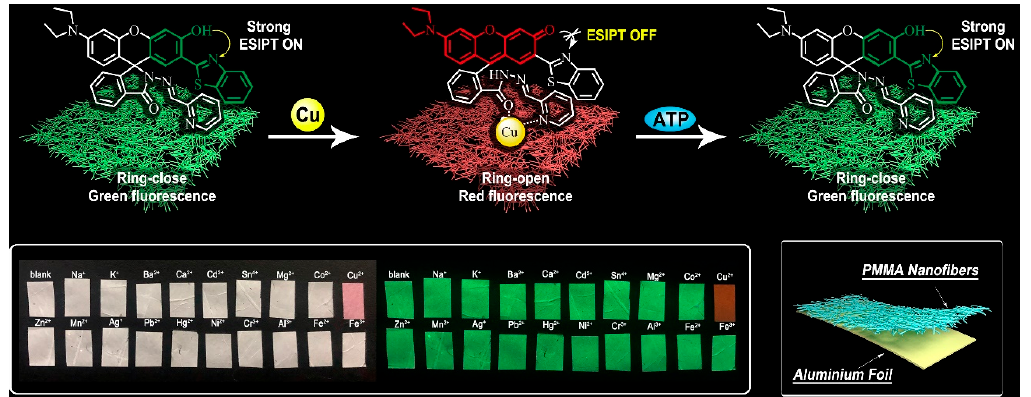
Figure 7. Schematic illustration of a ratiometric fluorescent sensing platform that uses a probe- doped PMMA material for the specific and visual detection of Cu 2+ and ATP sequentially, with photographs of the nanofibers exposed to different metal ions that confirm the selectivity of the platform (reproduced with permission from [182], copyright © 2020,